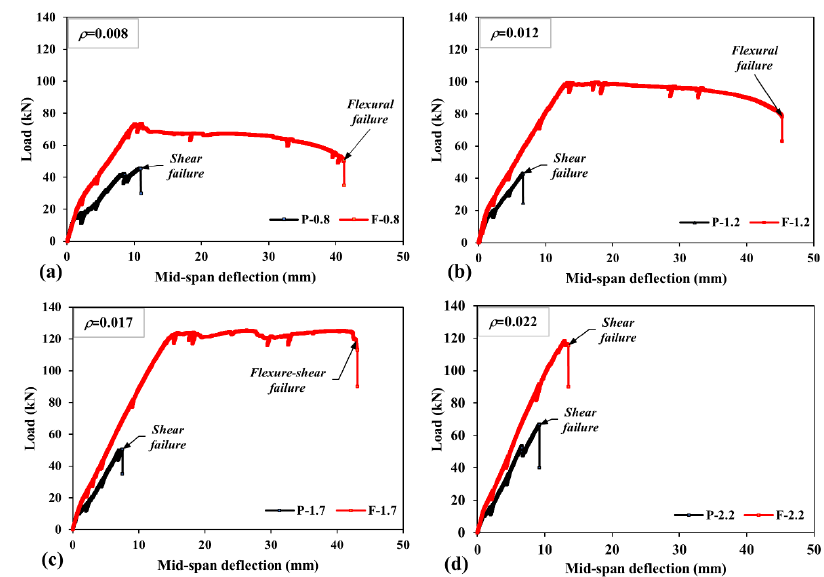
Figure 6. Load-deflection curves of test beams, ( a ) ρ = 0.008, ( b ) ρ = 0.012, ( c ) ρ = 0.017, ( d ) ρ = 0.022. Table 4. The main deflection and load results.